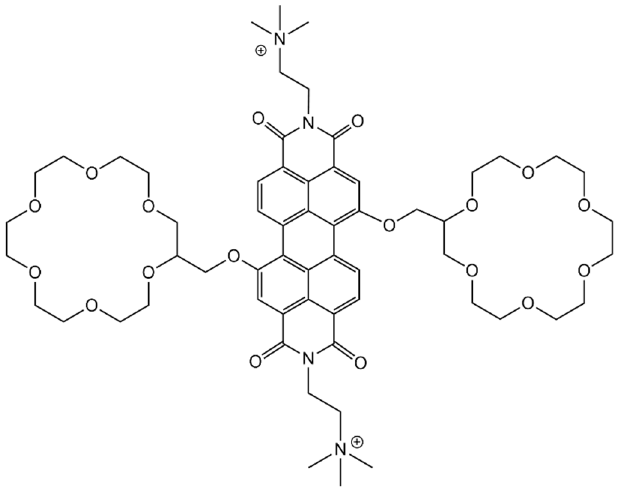
Figure 23. Structure of the crown ether molecular tweezer, perylene bisimide dye (PBI) [153].